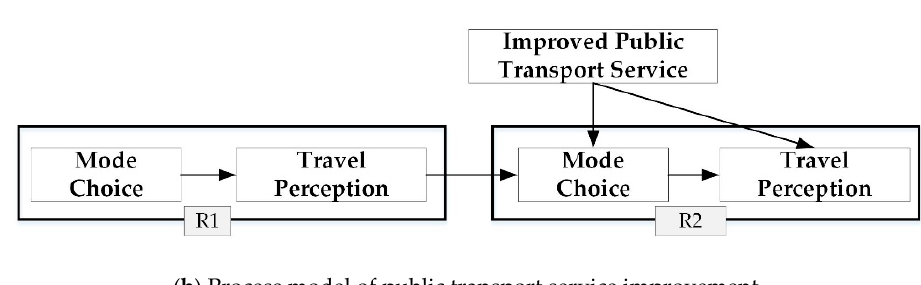
Figure 4. Framework of the process model.